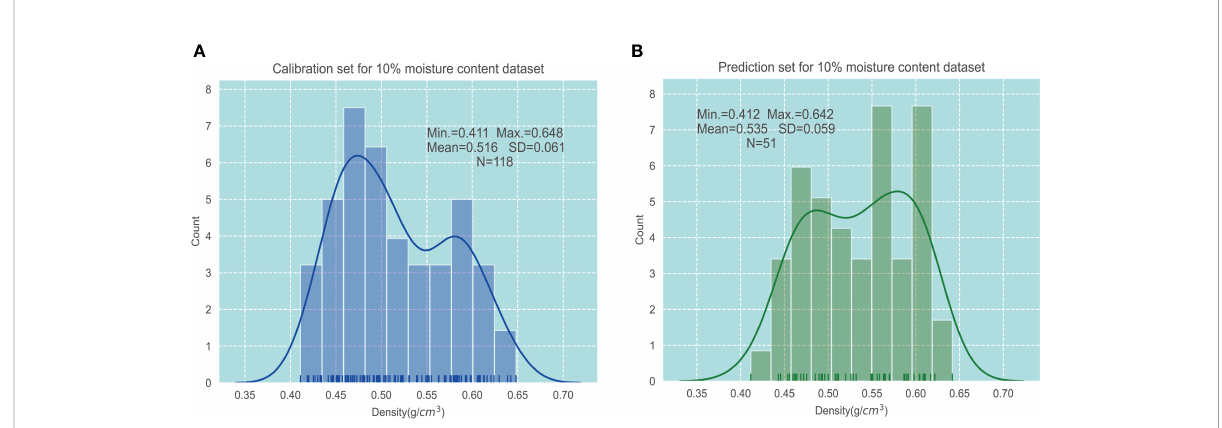
FIGURE 5 Descriptive statistics of wood density in 10% moisture content dataset. (A) Calibration set. (B) Prediction